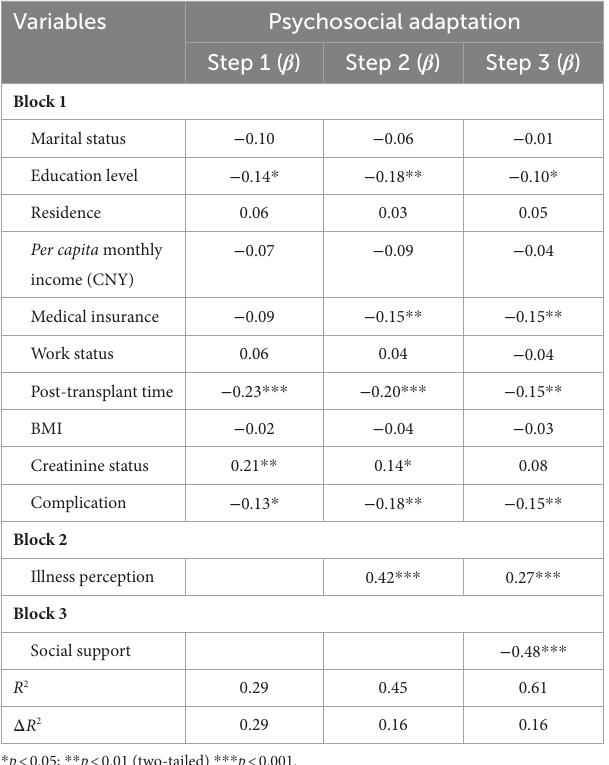
TABLE 2 Means, SDs, and correlations of all variables. TABLE 3 Hierarchical multiple linear regression analysis